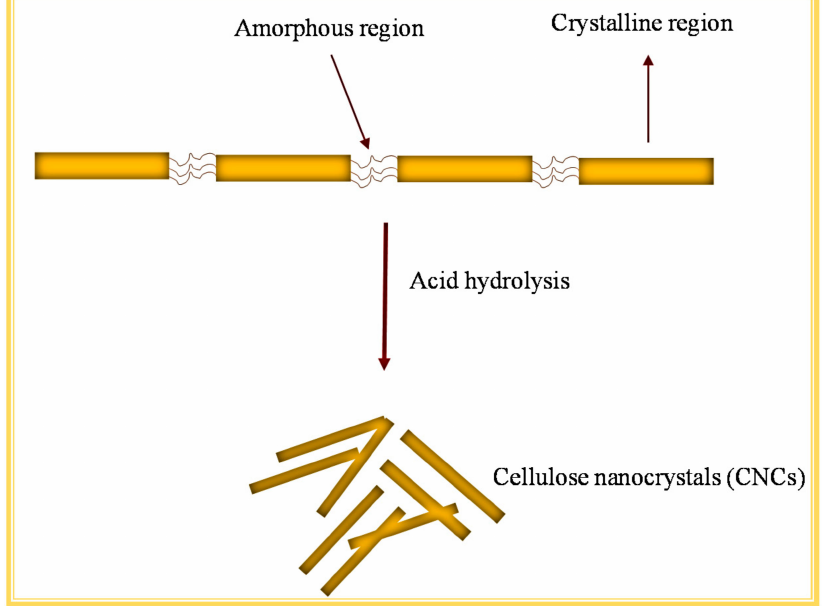
Figure 4. The process of CNC extraction using the conventional acid-hydrolysis